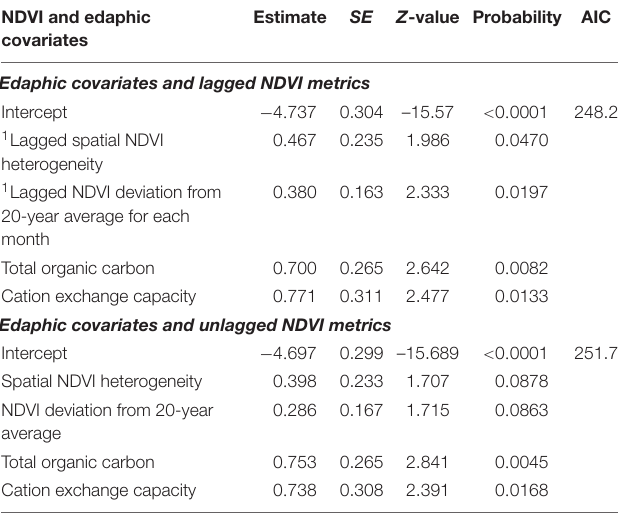
TABLE 8 | Best multivariate logistic model combining edaphic and NDVI-metric predictors of the monthly occurrence of anthrax in wildlife focal areas showing lagged and unlagged NDVI metrics.